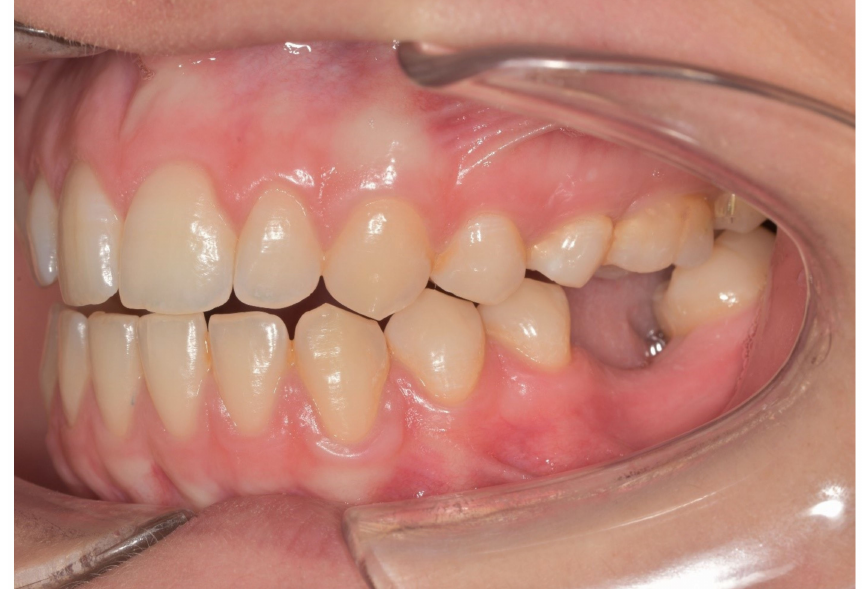
Figure 1. Preoperative evaluation of the patient.